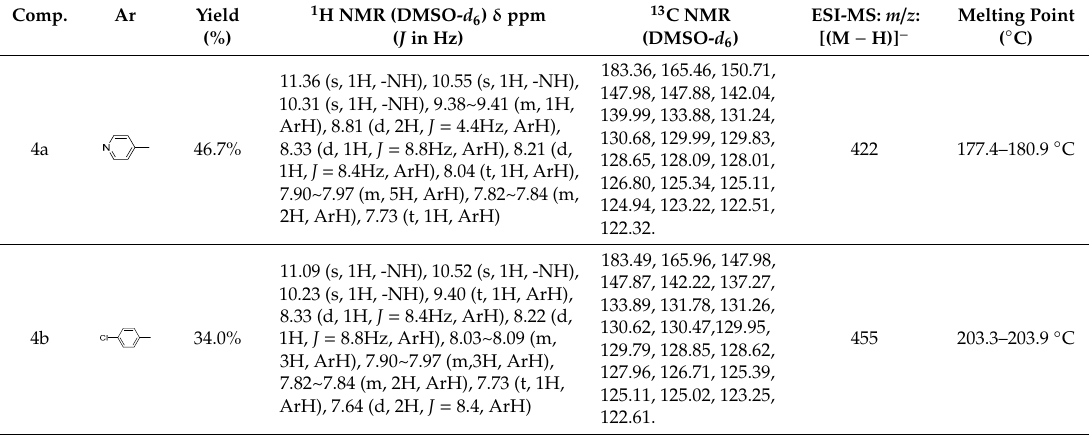
Table 1. The spectral data of the compounds ( 4a–4e ).